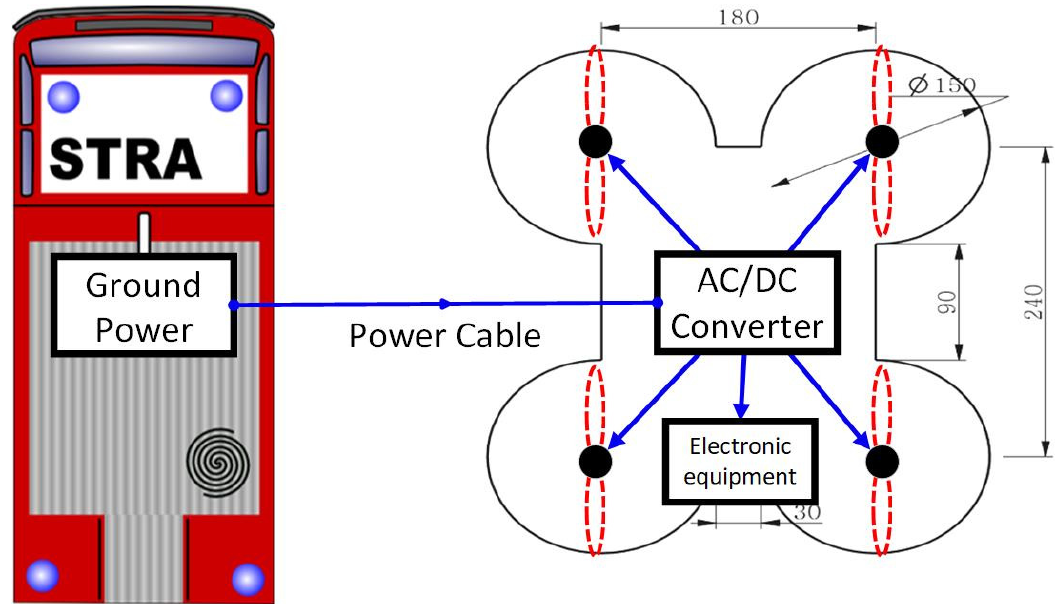
Figure 5. Layout of heavy-lift tethered multicopter for lifesaving Mission.